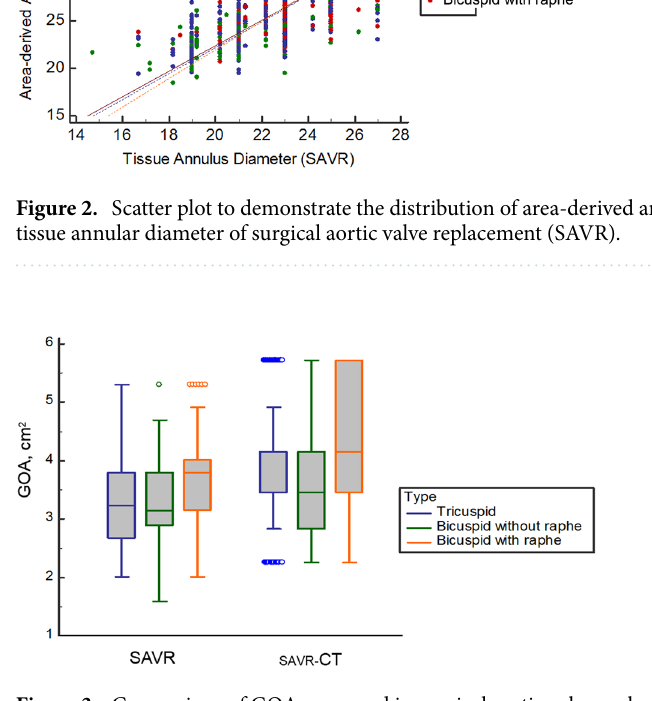
Figure 3. Comparison of GOA measured in surgical aortic valve replacement (SAVR) and CT-derived geometric orifice area ( SAVR -CT) according to the native valve types. GOA, geometric orifice area; SAVR, surgical aortic valve